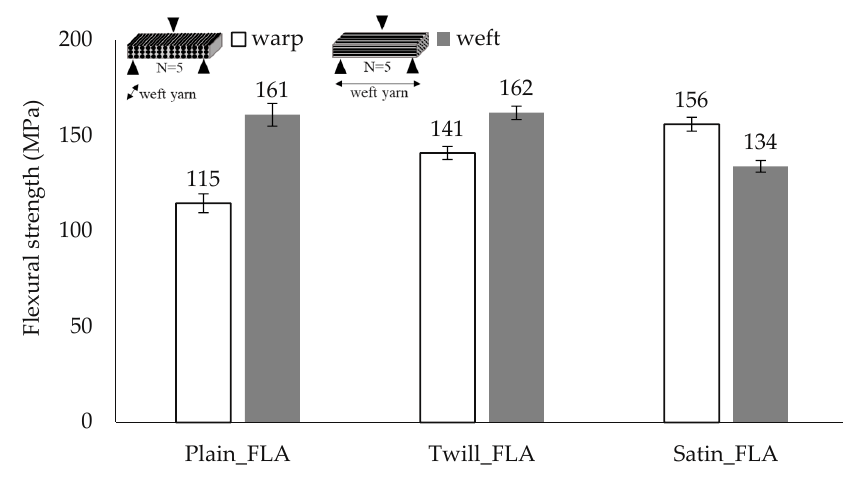
Figure 7. Flexural strength of flax composites.